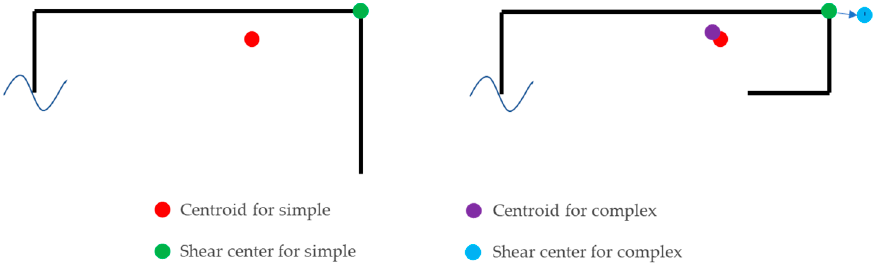
Figure 1. Geometric features of the flange and edge stiffeners.